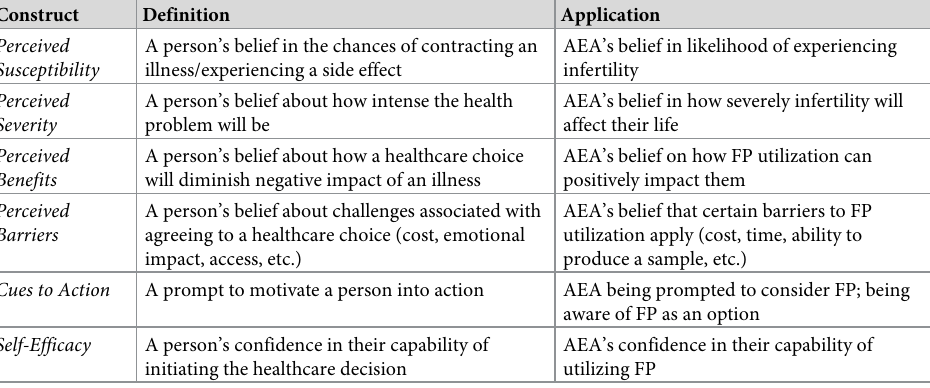
Table 1. Health Belief Model key concept definitions and